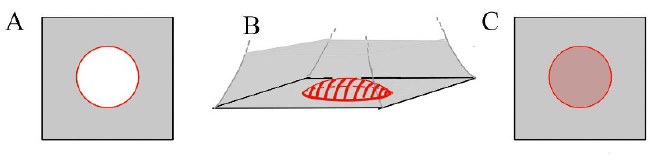
Figure 1 . Basic setup. A) Our thermal system, dual to a bulk black hole, is the red boundary. It interacts with a bulk CFT which can serve as an auxiliary system to which the black hole can radiate. B) Higher-dimensional bulk picture: the red surface is a dynamical ‘end-of-the-world’ (ETW) brane whose tension is monotonically related to the number of local degrees of freedom in the boundary system. For large tension, this ETW brane moves close to the boundary and behaves like a Randall-Sundrum Planck brane. C) The Planck-brane picture suggests an e(cid:11)ective lower- dimensional description where a part of the CFT in the central region is replaced with a cuto(cid:11) CFT coupled to gravity, similar to the setup in